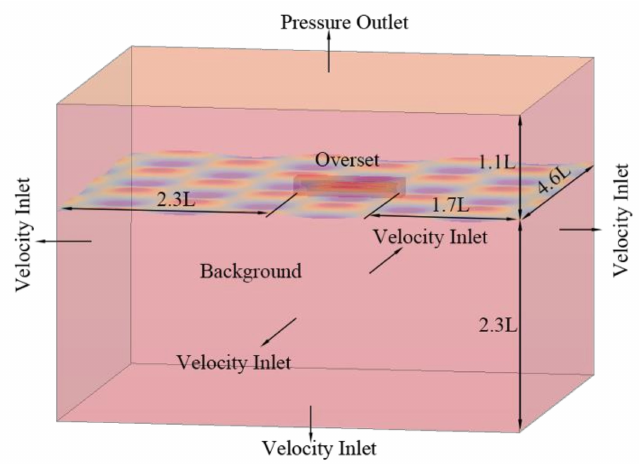
Figure 5. Overview of the fluid domain.